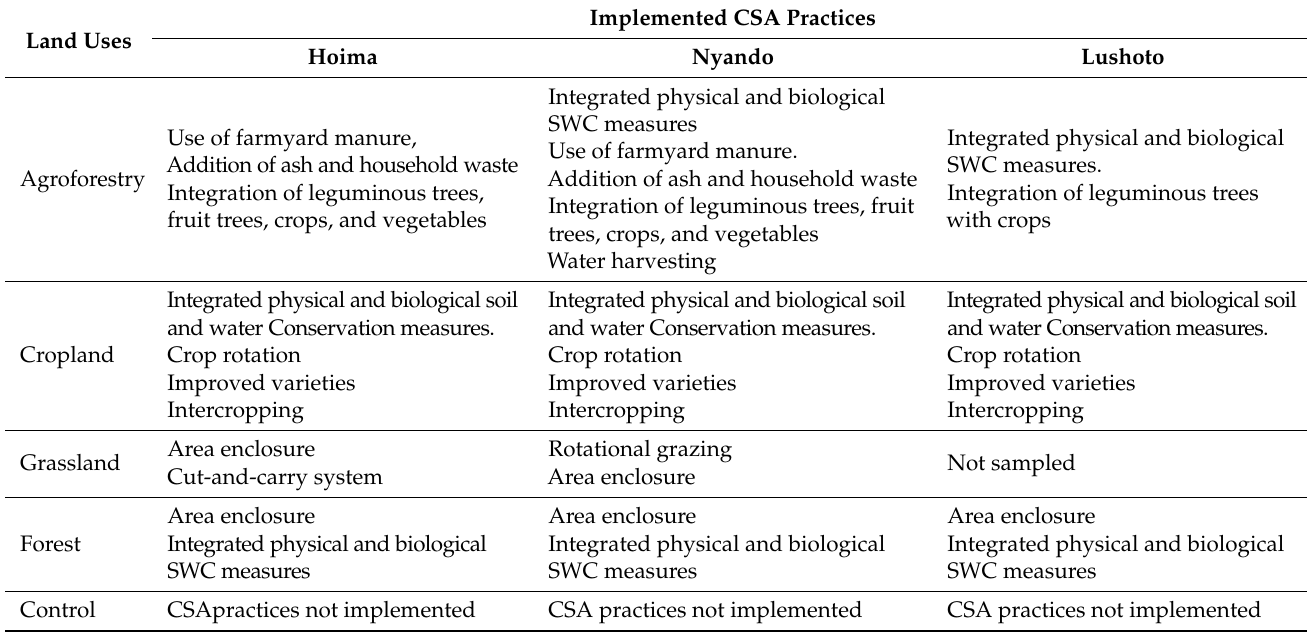
Table 1. CSA practices implemented in different land uses across Hoima (Uganda), Nyando (Kenya) and Lushoto (Tanzania)